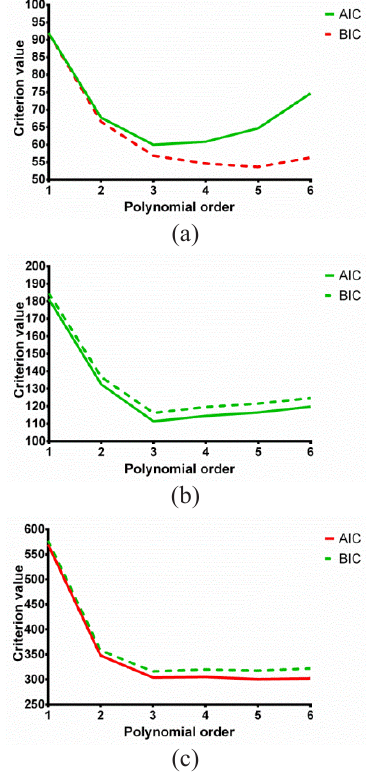
Fig. 6. Comparison of the effectiveness of AIC and BIC: (a) 15 points generated, (b) 31 points generated, (c) 101 points